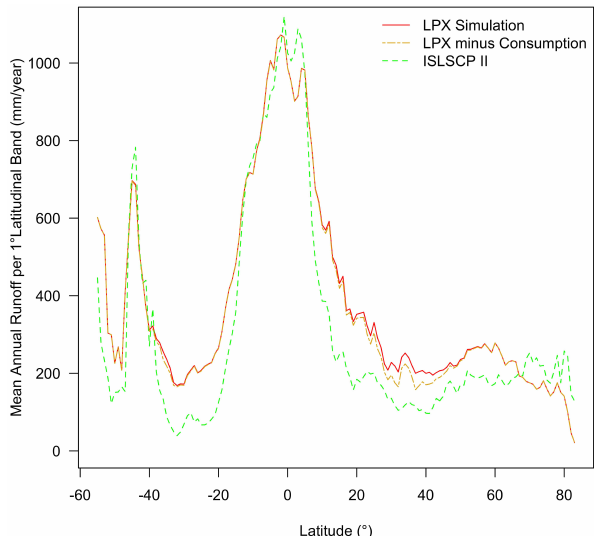
Fig. 3. Mean Global Annual Runoff Distribution for the period 1986–1995 per 1 ◦ latitudinal band as simulated by LPX and as represented by the ISLSCP II composite dataset. Freshwater consumption is based on WaterGAP